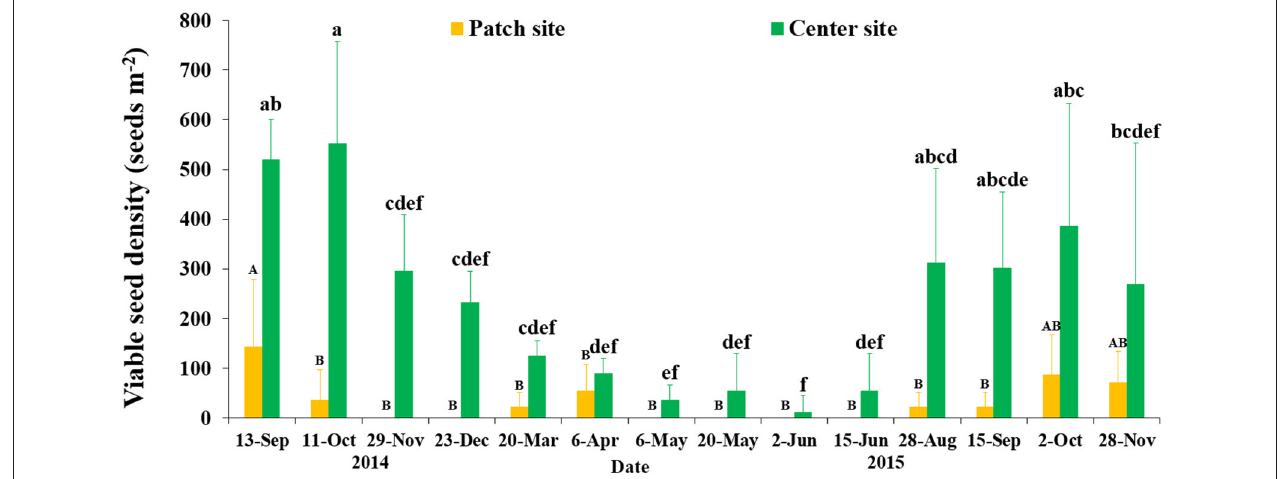
FIGURE 7 | Temporal changes in the seed bank densities of Zostera marina at the two study sites in Swan Lake. Values are means ± sd . Different capital or small letters denote significant differences ( p < 0.05).